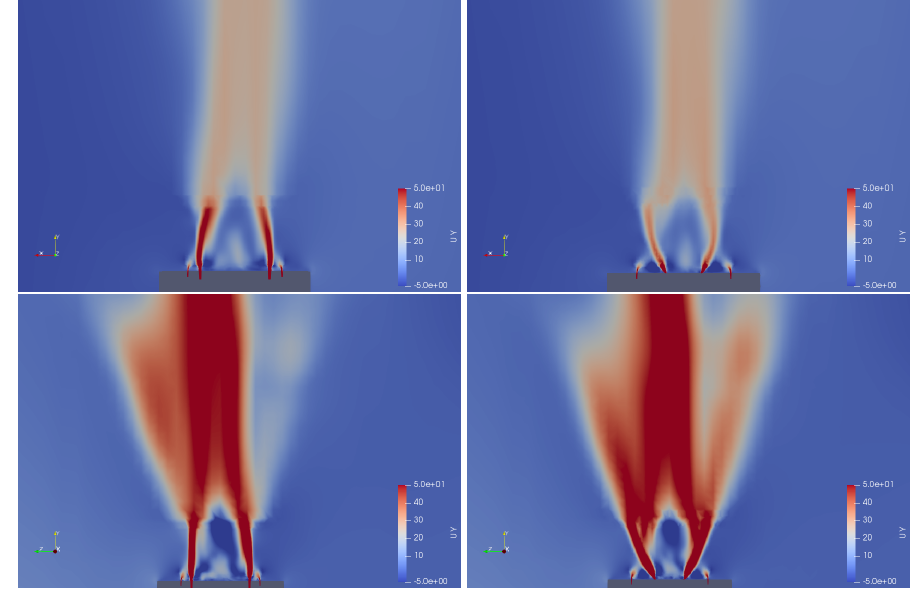
Figure 5. Clipped axial velocity in m/s of the fuel jets exiting from the axial ( left ) and inclined nozzles ( right ) and the primary air stream in the non-reactive ( top ) and reactive ( bottom )